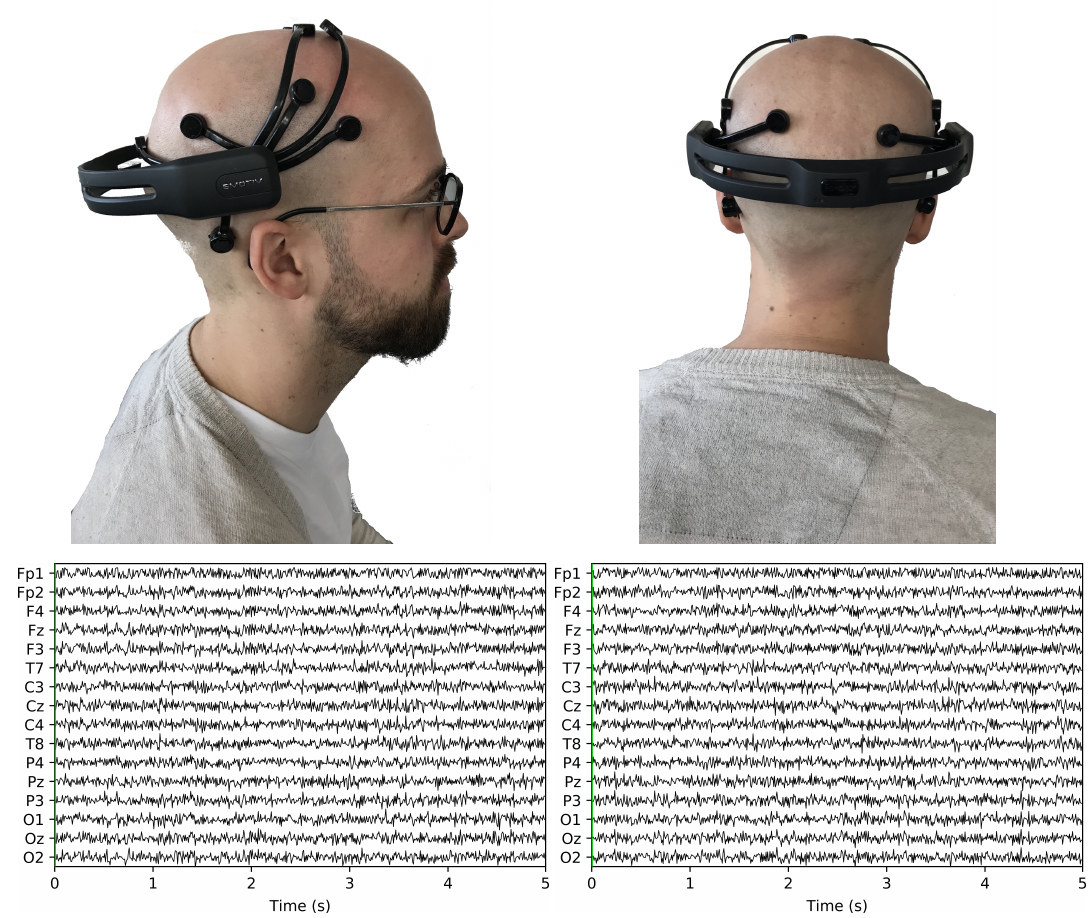
Figure 5. Data Collection. ( a ) EEG Low Cost Portable Sensor; ( b ) EEG Low Cost Portable Sensor; ( c ) 5 s of the recorded EEG-data for the HKT leader Subject 1; ( d ) 5 s of the recorded EEG-data for the